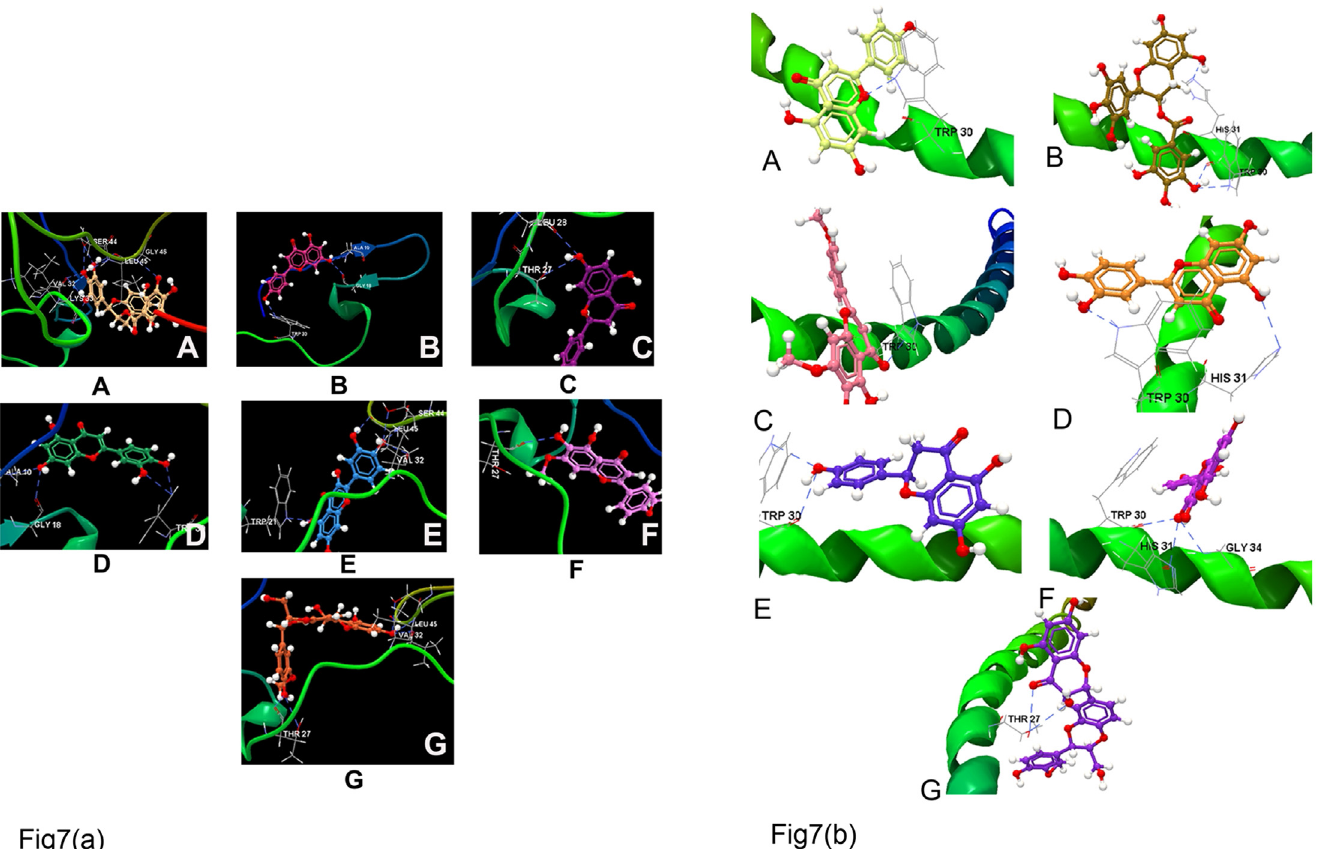
Fig 7. In silico docking study of p7 model of GT3 and GT4 with flavonoids. (A) Snapshots of molecular interactions of GT3 p7 model with different flavonoids such as (a) Epigallocatechin-3-gallate, (b) Apigenin, (c) Naringenin, (d) Luteolin, (e) Quercetin, (f) Ladanein, and (g) Silymarin. Hydrogen bonds have been shown as blue dashed lines. (B) Flavonoid interactions with the GT4 p7 model (shown as green ribbon). (a) Apigenin, (b) Epigallocatechin- 3-gallate, (c) Ladanein, (d) Luteolin, (e) Naringenin, (f) Quercetin, and (g) Silymarin. Hydrogen bonds have been shown as blue dashed lines.